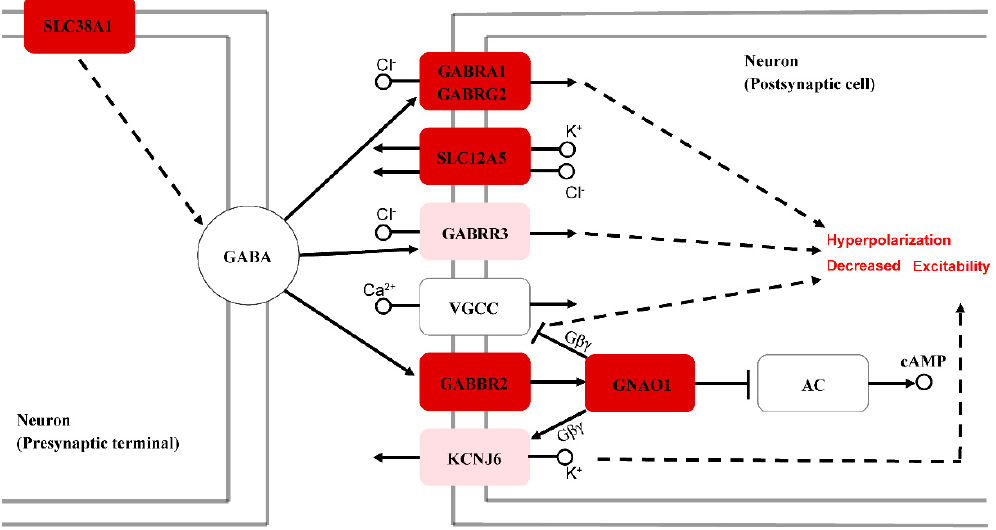
Figure 6. Regulatory mechanisms of six genes in the GABAergic synapse pathway (AC: adenylyl cyclase). The genes with high expression in males are shown in different shades of red boxes (fold change increases from light to dark red). The expression levels of genes between males and females in the light red boxes are shown in Figure S2.